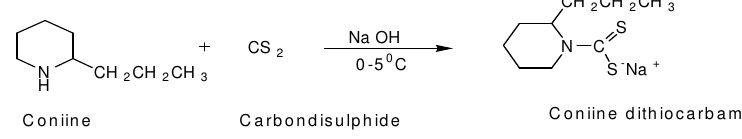
Figure 1. Synthesis of conline dithiocarbam ate